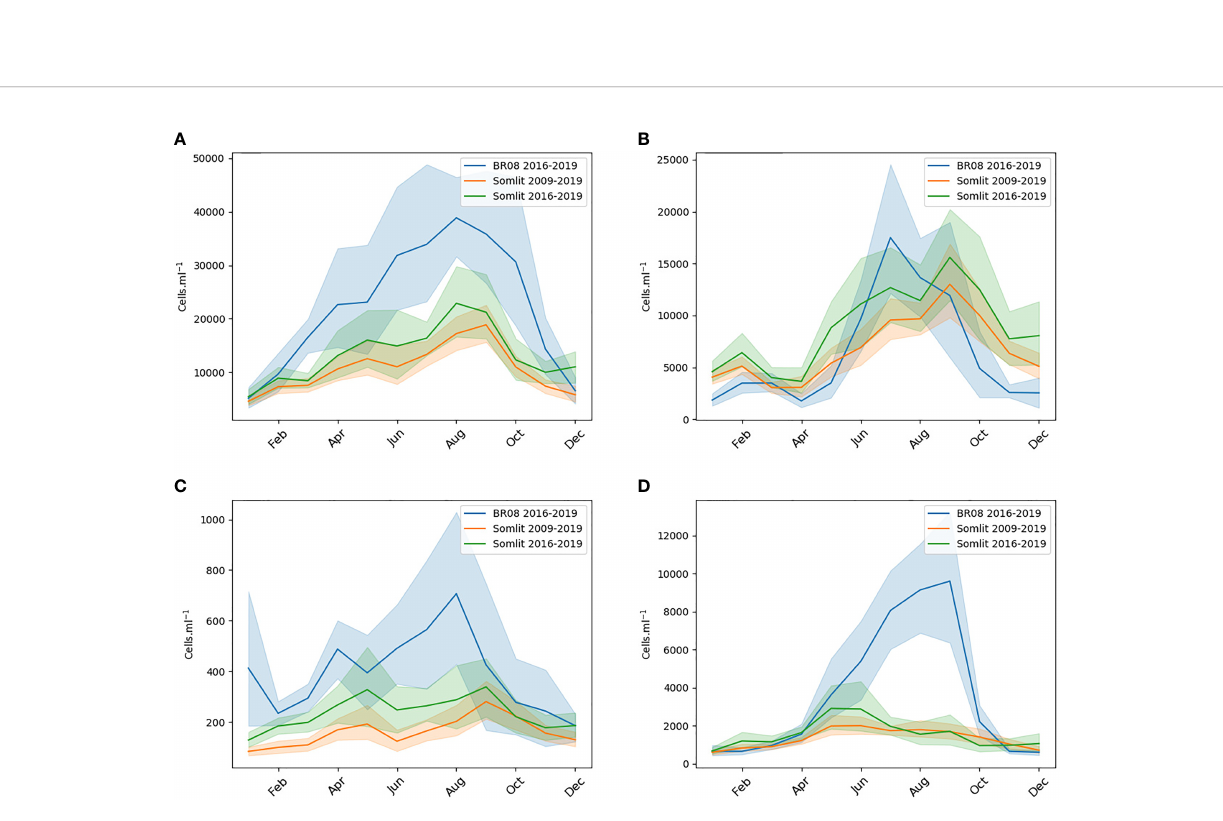
FIGURE 5 | Seasonal patterns of monthly average and standard deviation) observed by the IFC in the Daoulas Estuary (station D, Figure 2 , blue line) during 2016- 2019 for the Picoeukaryotes, Synechococcus , Cryptophyceae and Nanophytoplankton clusters (A – D) . The seasonal pattern at the entrance of the Bay was estimated from the SOMLIT-Brest station (station A) for the same and a longer period (green and red line